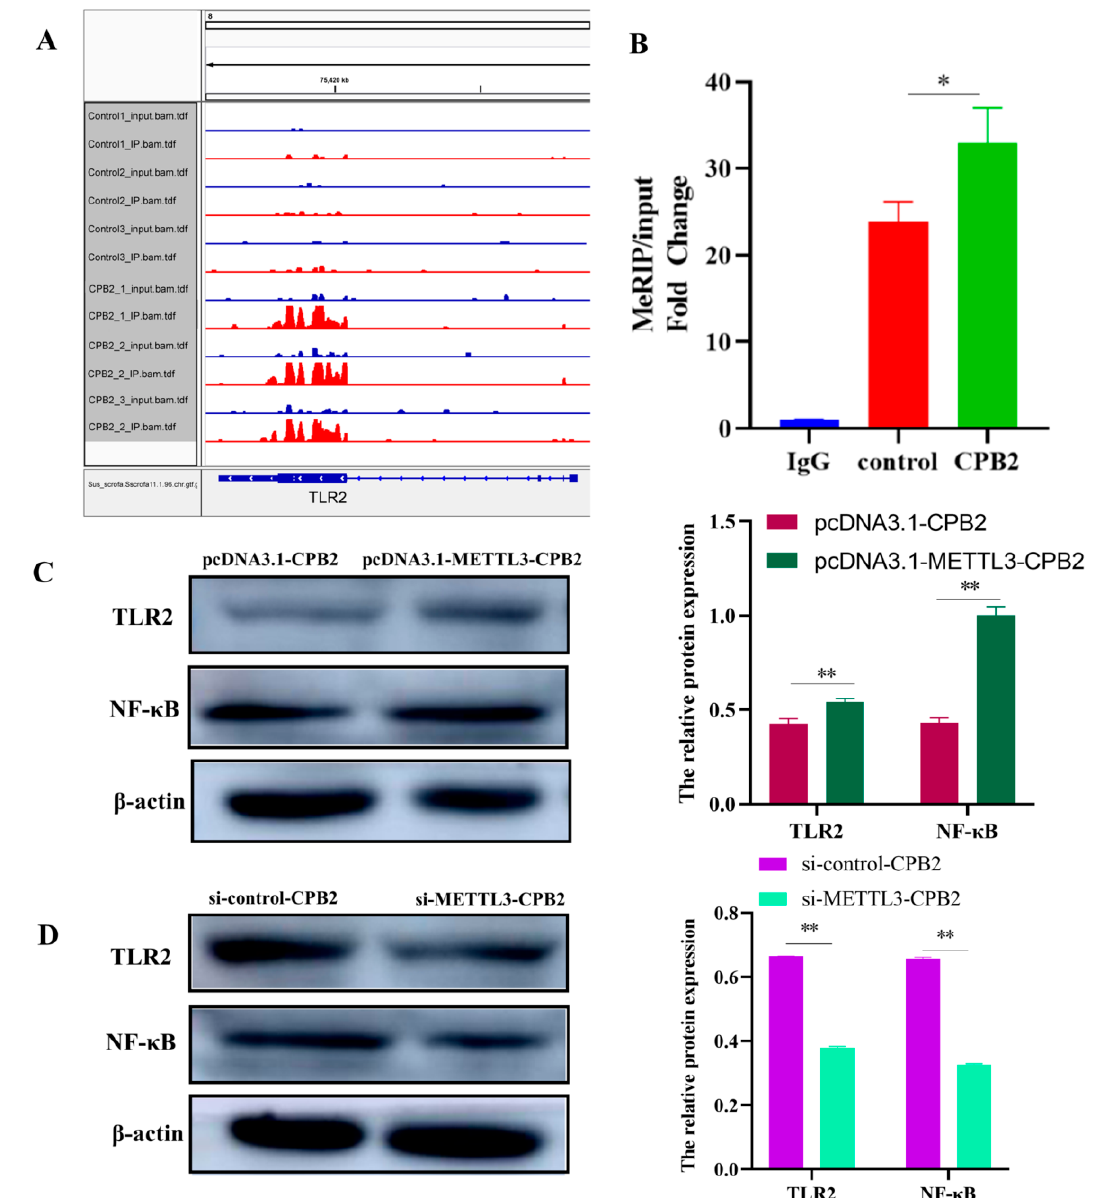
Figure 7. TLR2/NF-B pathway effects of METTL3 overexpression and knockdown in CPB2-exposed IPEC-J2 cells. ( A ) TLR2 m6A peak distribution in the control and CPB2 groups using the Integrative Genomics Viewer (IGV) program. ( B ) MeRIP-qPCR analysis of TLR2 m6A expression in IPEC-J2 cells exposed to CPB2. ( C , D ) TLR2 and NF- κ B protein expression in CPB2-exposed cells following METTL3 overexpression and knockdown. Figure 3 shows the group annotations. All data are based on three separate trials and presented as mean ± SD. ** p < 0.01 and * p < 0.05.